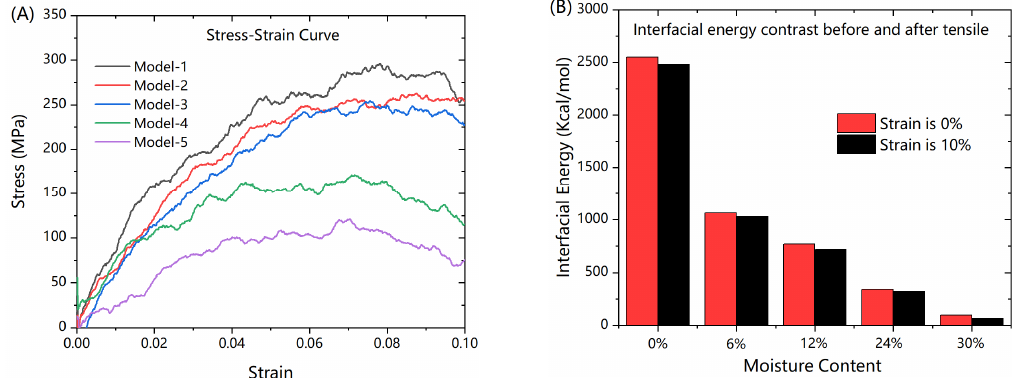
Figure 5. Stress-Strain Curve and evolution of interfacial energy ( A ) Stress-Strain Curve in loading direction, ( B ) Absolute interfacial energy change in loading